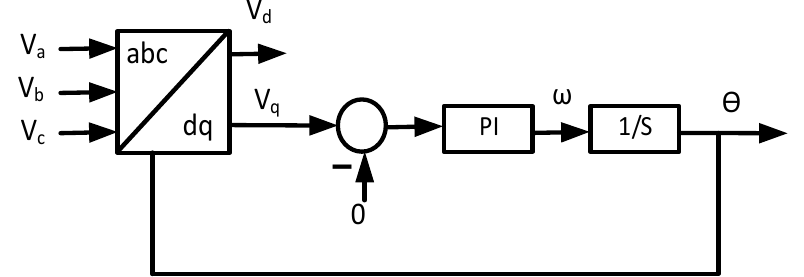
Figure 9. The PLL control